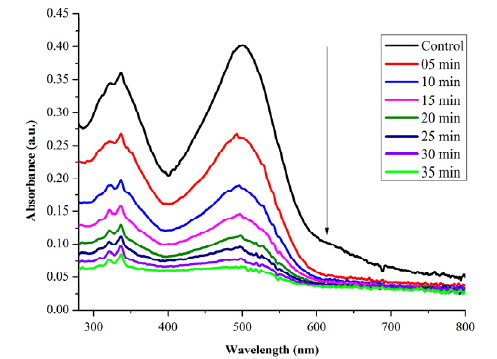
Fig. 10. Spectrum analysis of Congo red dye degradation of Pogostemon speciosus SNPs